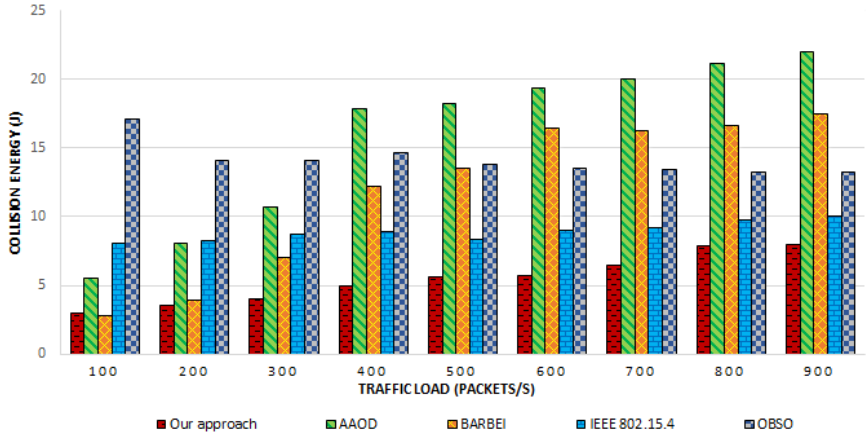
Figure 8. Collision energy consumption.